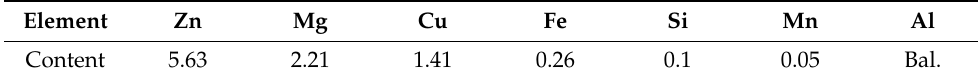
Table 1. Chemical composition of 7075 alloy (wt %).